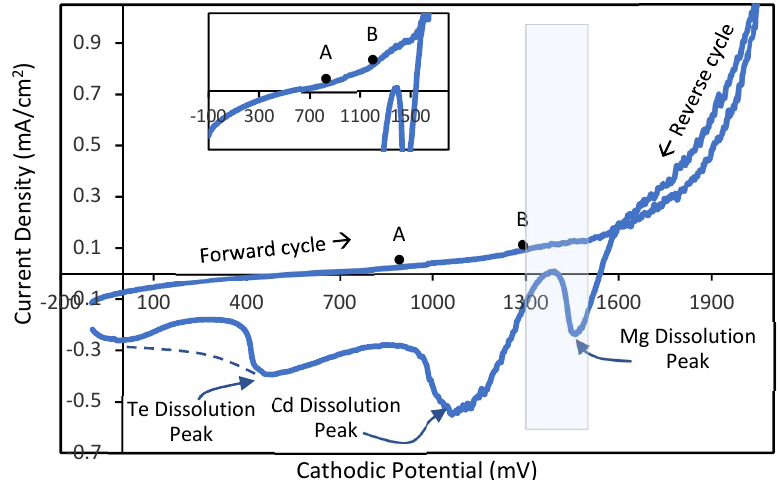
Figure 1. Typical cyclic voltammogram of an aqueous solution containing Cd(NO 3 ) 2 · H 2 O, MgSO 4 , and TeO 2 as precursors. pH and temperature of the solution was kept at 4.00 ± 0.02 and ∼ 85 °C, respectively.